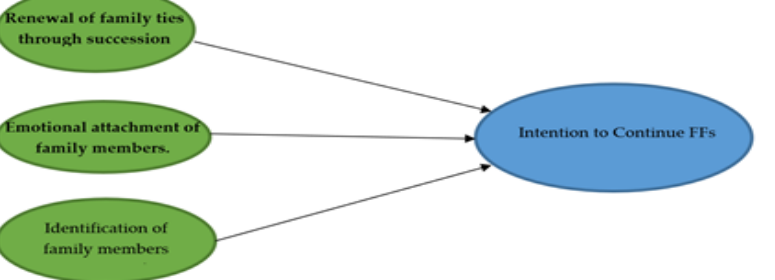
Figure 5. REI scale and intention to continue FFs. A comparative inferential analysis. Intention to continue the FFs depending on SEW student’s